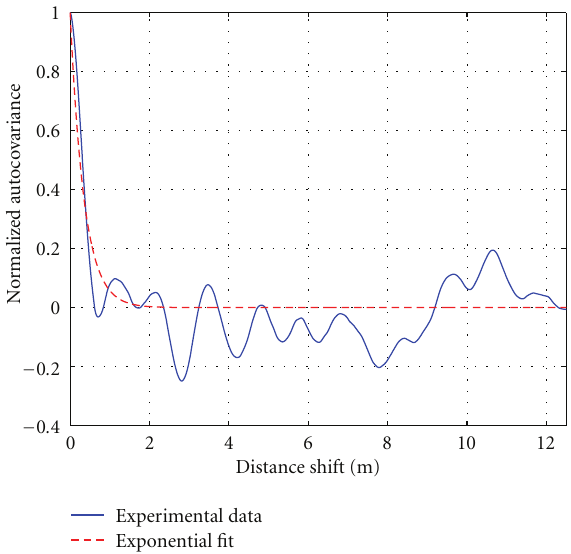
Figure 11: Exponential match for the normalized autocovariance of the log of shadowing variations. It can be seen that exponential provides a good